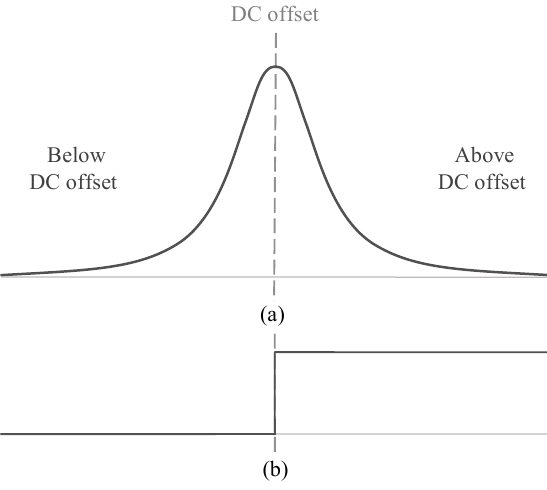
Fig. 5. Comparator output (b) depending on the noise signal input (a)